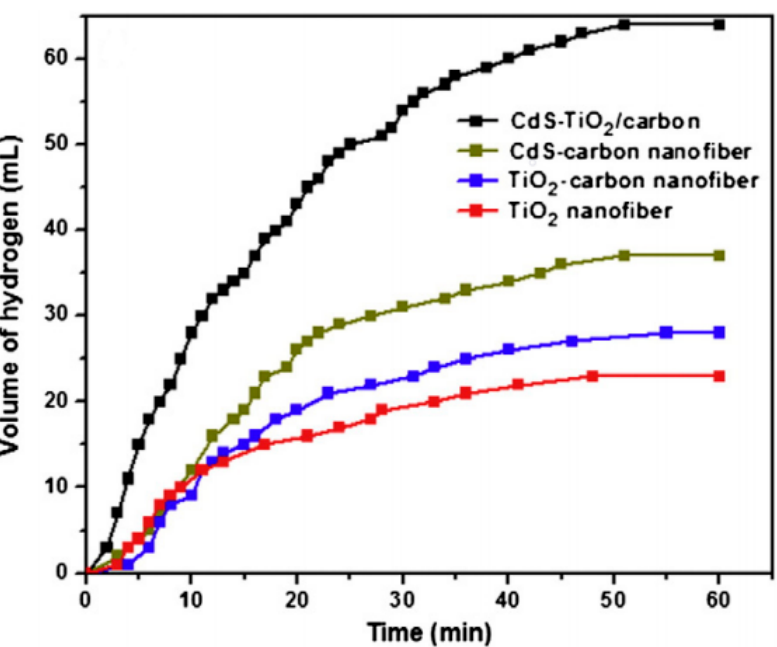
Figure 21. Photocatalytic performance of TiO 2 NFs with and without the incorporation of CdS and C NFs for AB hydrolysis reaction. Reprinted from reference [112] with permission from Elsevier. The reusability of CdS–TiO 2 /C NFs was studied by testing the photocatalytic per- formance of the same sample three times. H 2 production was lower in the second and third cycles. This may be due to the decrease in the adsorption activity with the time of the